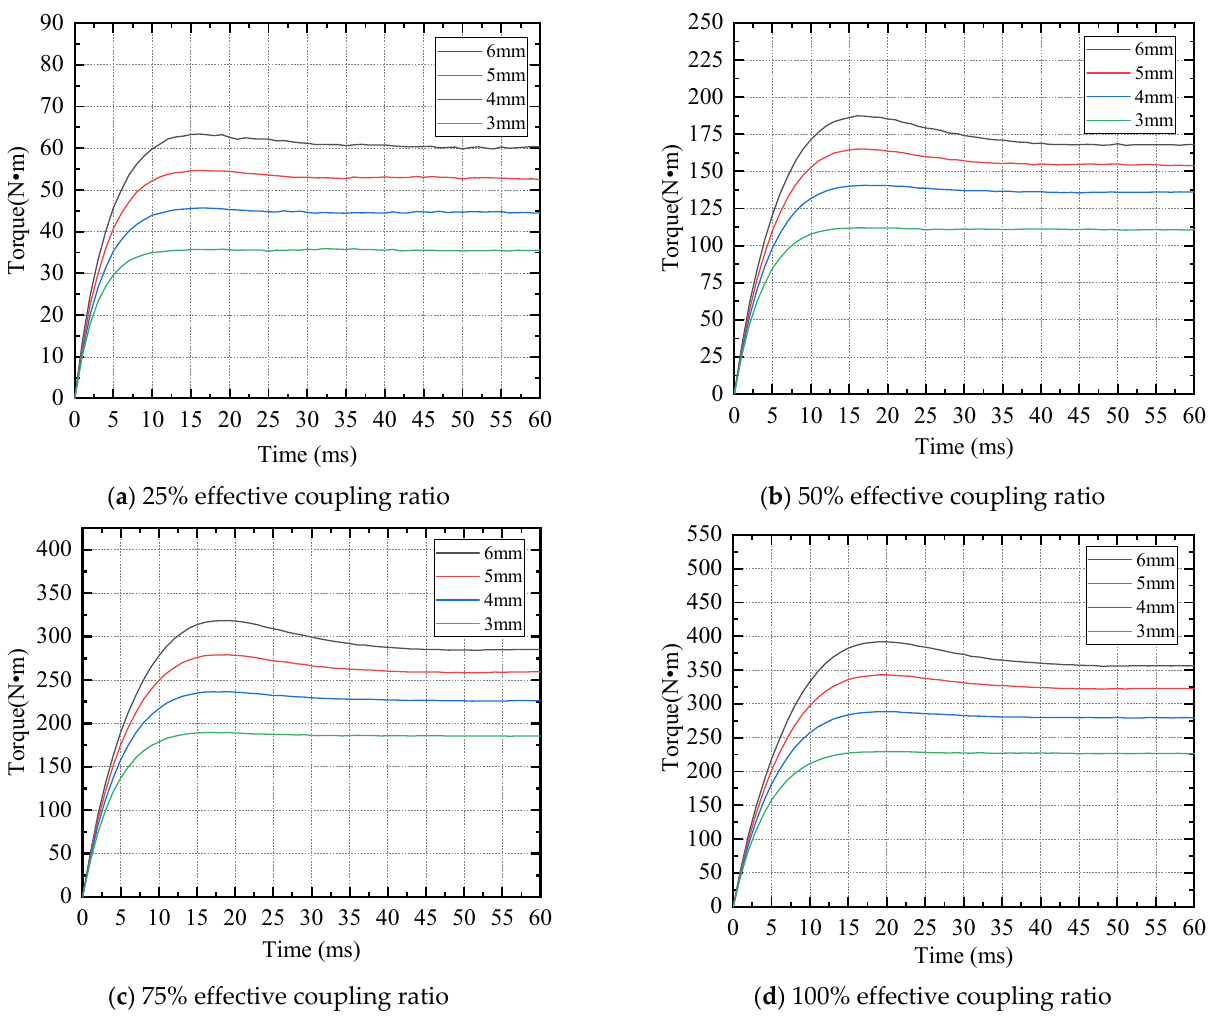
Figure 14. Output torque of CPMG under different copper ring thicknesses.